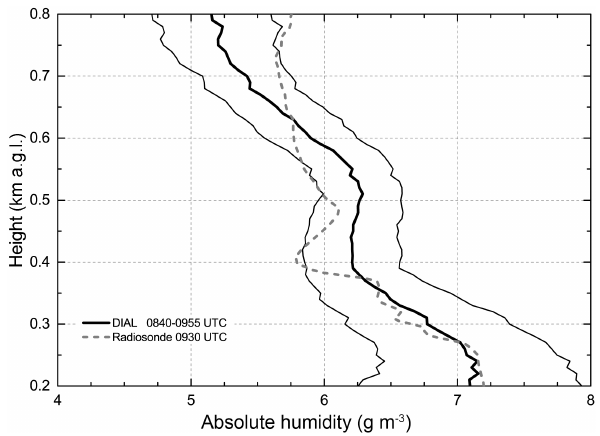
Figure 11. Spatially averaged absolute humidity profiles of the vol- ume scan of Fig. 10 (08:40–09:55UTC). The thick solid line shows the mean profile of the scanned volume and the thin lines indicate the horizontal WV variability (1 σ standard deviation) within the scan range. The radiosonde profile launched at 09:30 UTC was plot- ted with a dashed line.